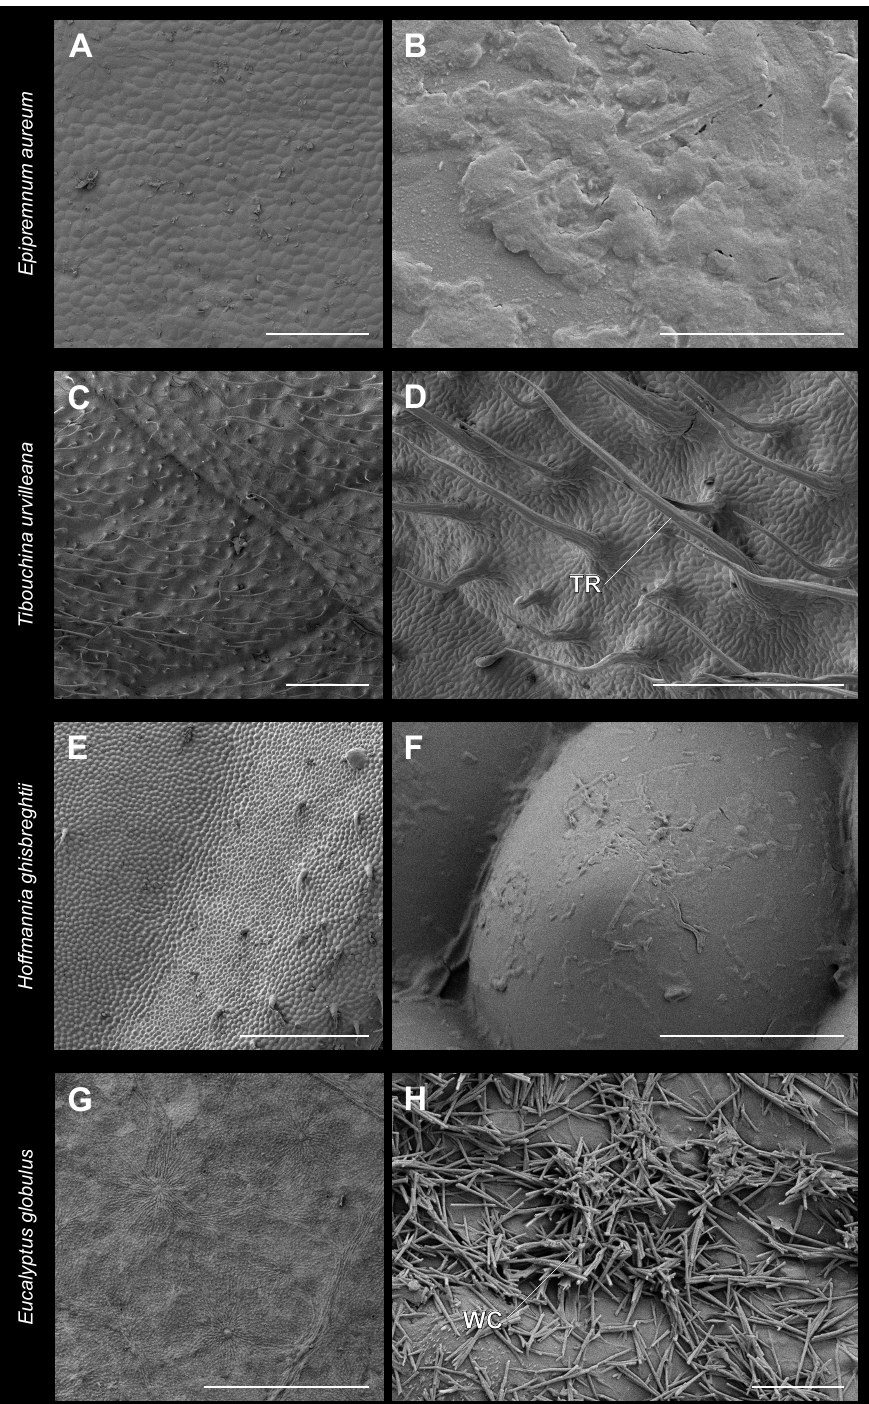
Figure 8. Cryoscanning electron microscopy images of the adaxial leaf surface. ( A , B ) Epipremnum aureum , ( C , D ) Tibouchina urvilleana , ( E , F ) Hoffmannia ghiesbreghtii , ( G , H ) Eucalyptus globulus . Scale bars: ( A , D ) = 400 µ m; ( B , H ) = 5 µ m; ( C , E , G ) = 1 mm, ( F ) = 20 µ m. TR: trichome; WC: wax